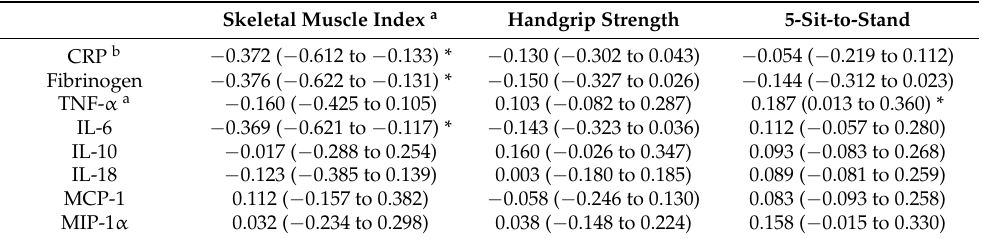
Table 2. Associations ( β -coefficients and 95% CI) between muscle health and pro- and anti- inflammatory biomarkers in older